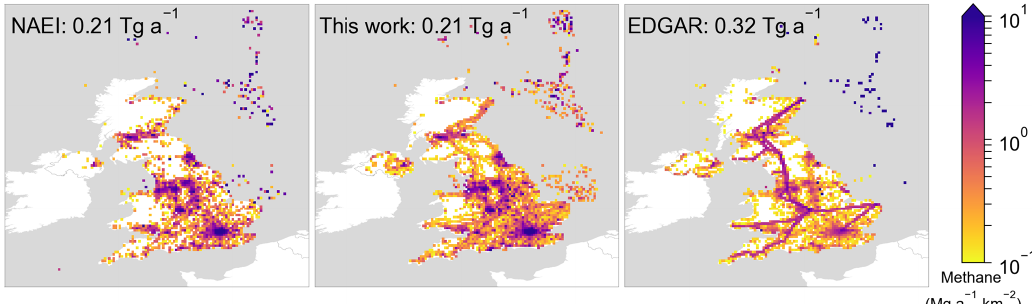
Figure 7. Methane emissions from fuel exploitation in the United Kingdom. Our inventory (for 2016) is compared to the gridded National Atmospheric Emissions Inventory (NAEI) for 2017 (Defra and BEIS, 2019) and EDGAR v4.3.2 for 2012 (European Commission, 2017). Emissions below 10 − 1 Mga − 1 km − 2 are not shown. National total emissions are given in the upper-left corner of each panel. We have masked EDGAR offshore emissions using the other two inventories.